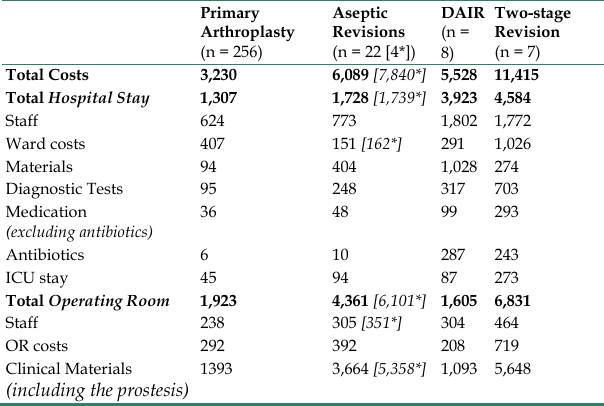
Table 4. Economic Data on 293 THA cases (average cost per patient in euros)